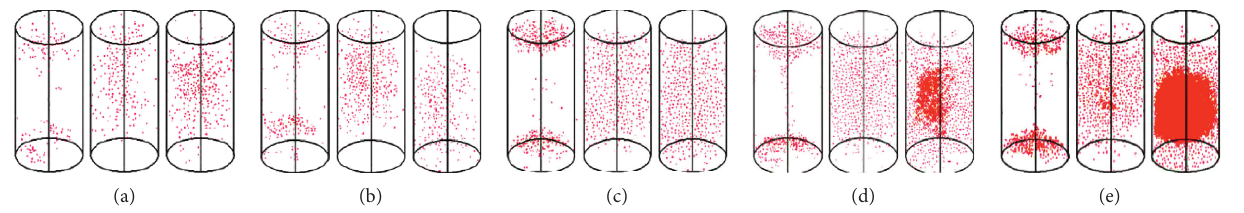
Figure 7: Time-space distribution characteristics of AE under different stress ratios (the time periods from left to right are 0 ∼ 5min, 5 ∼ 30min, and 30 ∼ 600 min, respectively): (a) stress ratio of 40%; (b) stress ratio of 50%; (c) stress ratio of 60%; (d) stress ratio of 70%; (e) stress ratio of 80% [100].